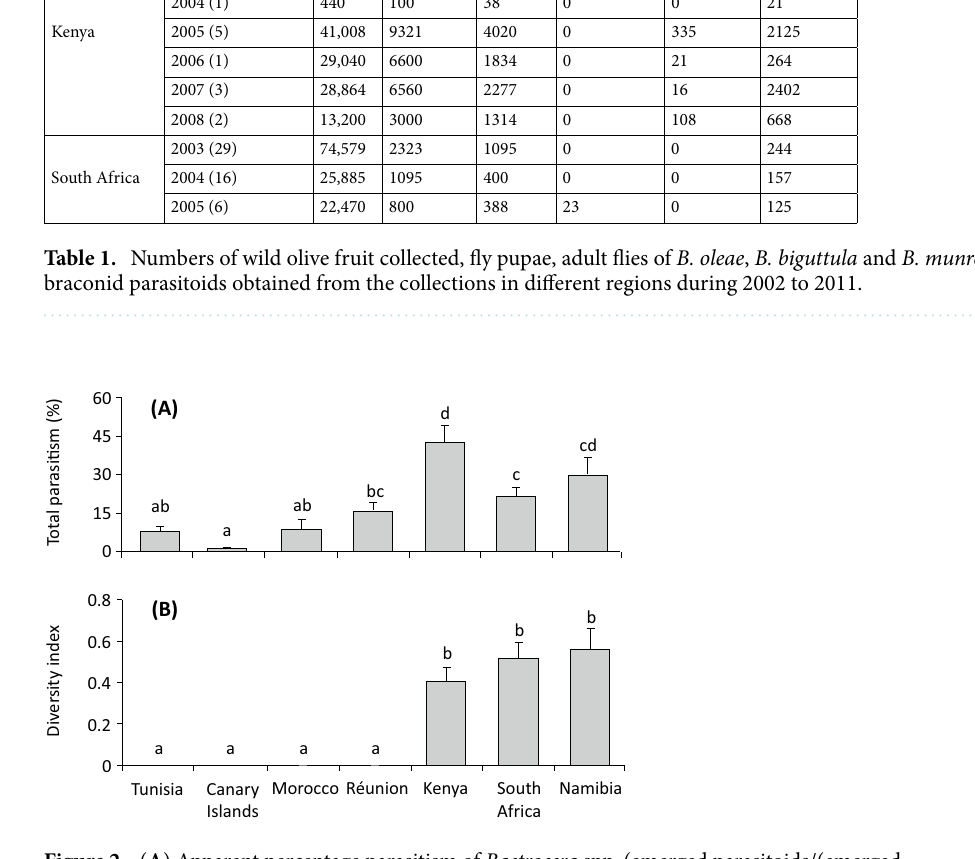
Figure 2. ( A ) Apparent percentage parasitism of Bactrocera spp. (emerged parasitoids/(emerged parasitoids + flies)) and ( B ) parasitoid species diversity (Shannon index) of the braconid parasitoid species reared from the collected flies in different regions in Africa; bars refer to mean and SE and different letters above the standard error bars indicate significant differences ( P < 0.05). PCA statistics and graphs were performed using JMP Pro ver13 (SAS, Cary,